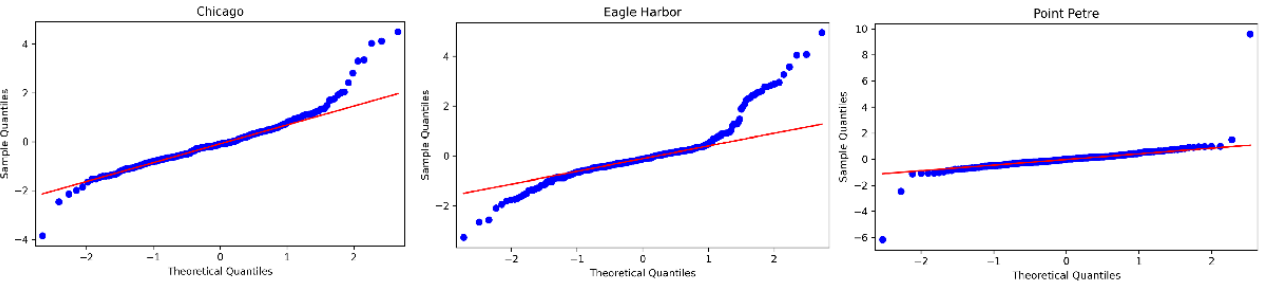
Figure 6. QQ plots of ARIMA model for three sites.